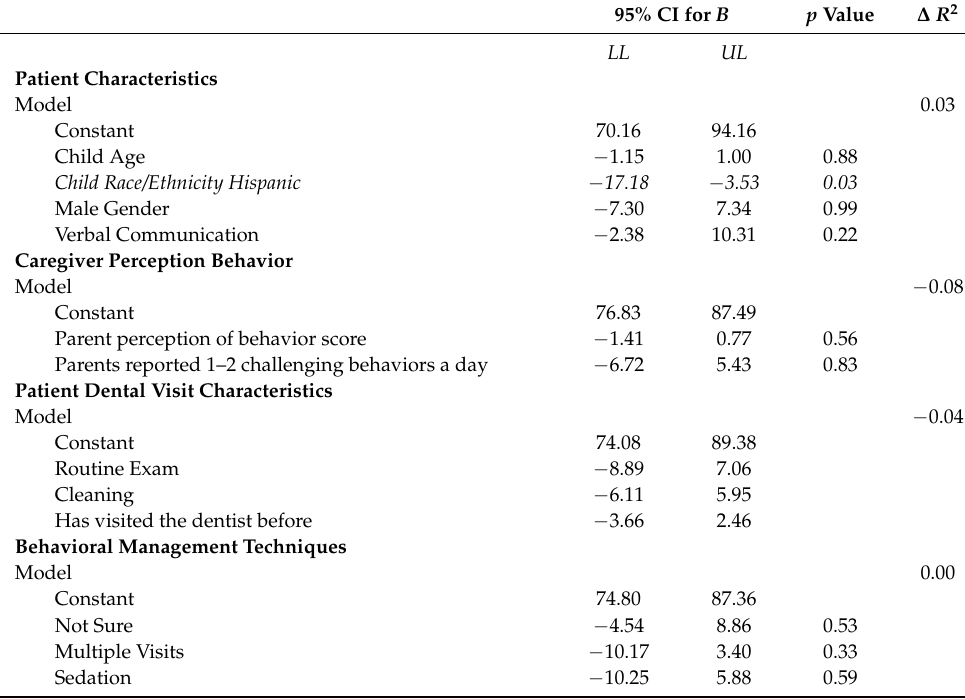
Table 5. Regression analysis to predict productivity level achieved during the first dental appointment, as measured by TAS Score (N = 205).